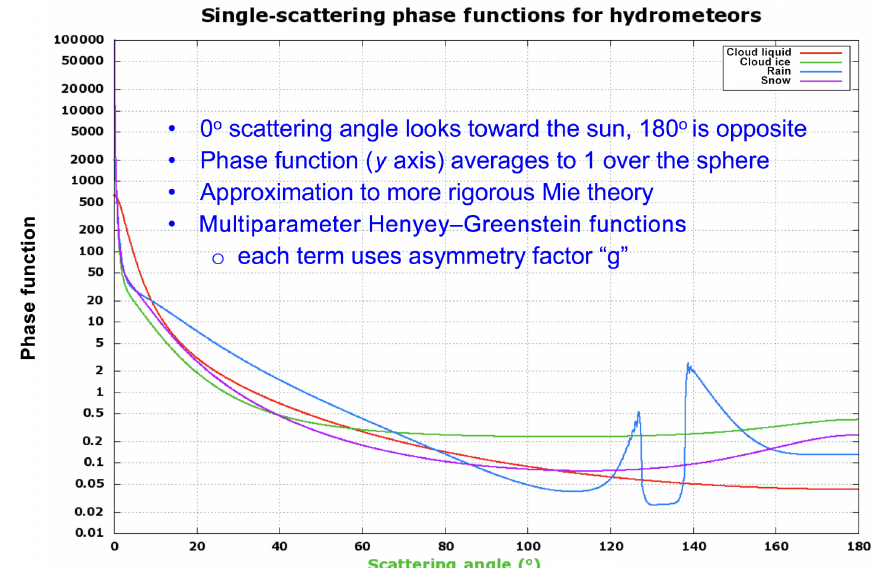
Figure 3. Single-scattering phase functions used for cloud liquid, cloud ice, rain, and